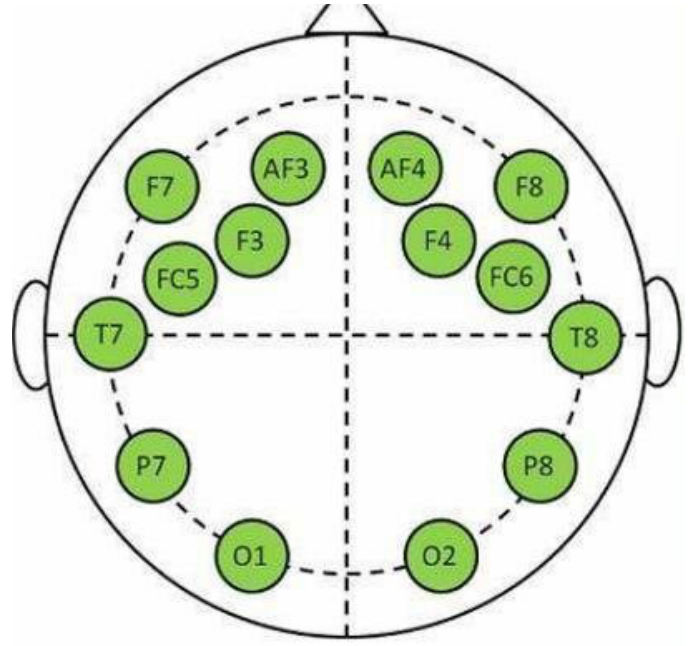
Figure 2. Location of the 14 channels of the Emotiv epoc+. Image from [50].